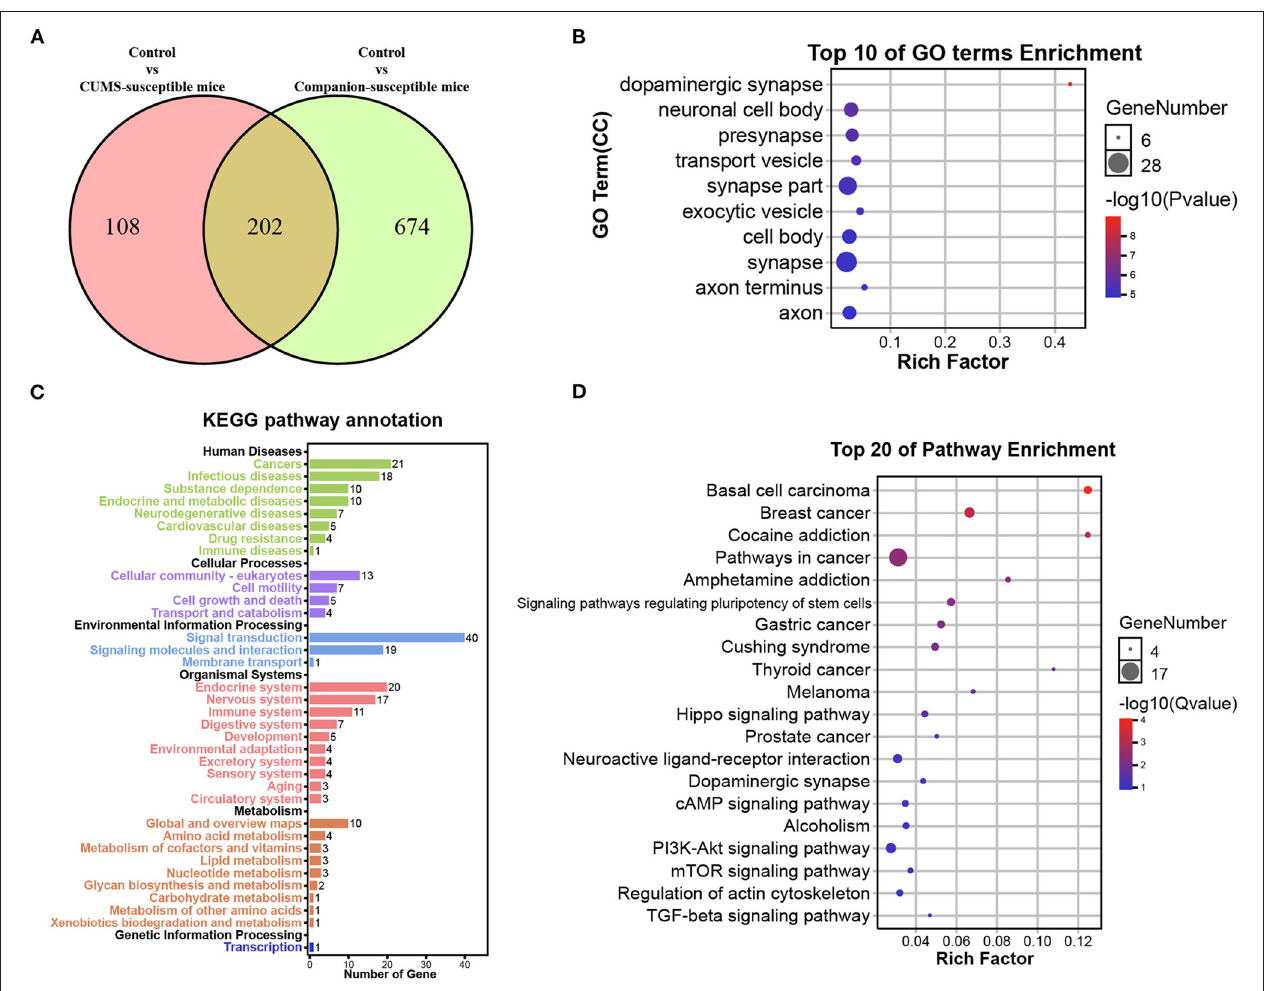
FIGURE 3 | Functional analysis of DEGs associated with depression-like behaviors in VTA. (A) Screening of DEGs associated with depression-like behaviors in Control vs. CUMS-susceptible mice and Control vs. Companion-susceptible mice through Venn diagram. (B) The histogram demonstrates common DEGs GO enrichment results, CC (cellular component). (C) KEGG pathway annotation for common DEGs. (D) The histogram demonstrates common DEGs KEGG pathway enrichment results, top 20 of pathway enrichment were